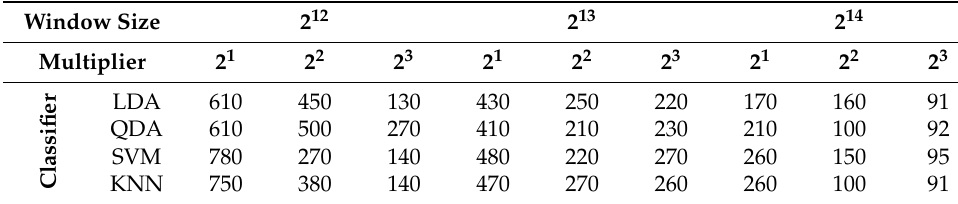
Table 3. Speed of classification (s − 1 ) of different classification methods. Window